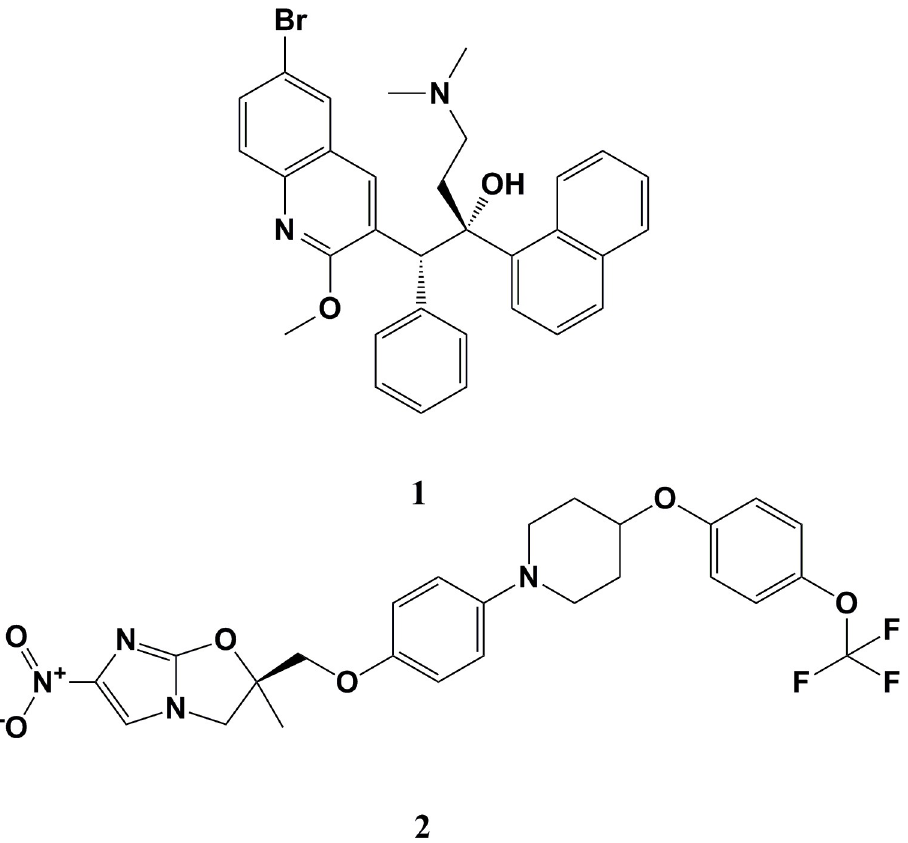
Fig 1. Chemical structure of clinically approved anti-TB drugs bedaquiline (1) and delamanid (2).